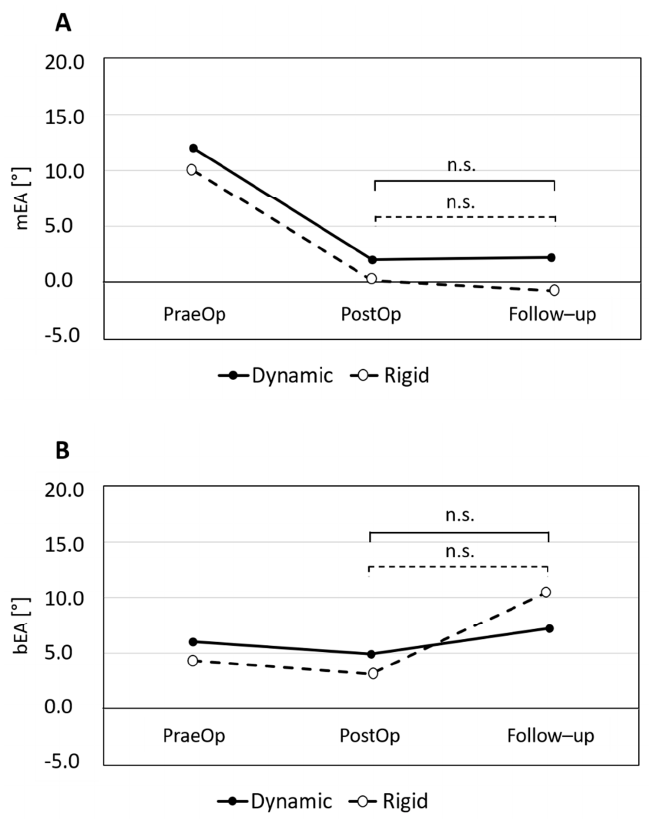
Figure 3. Changes in the mEA ( A ) and bEA ( B ) in the dynamic and rigid plate system. There was no significant loss of reduction during the follow up in both groups (A and B).